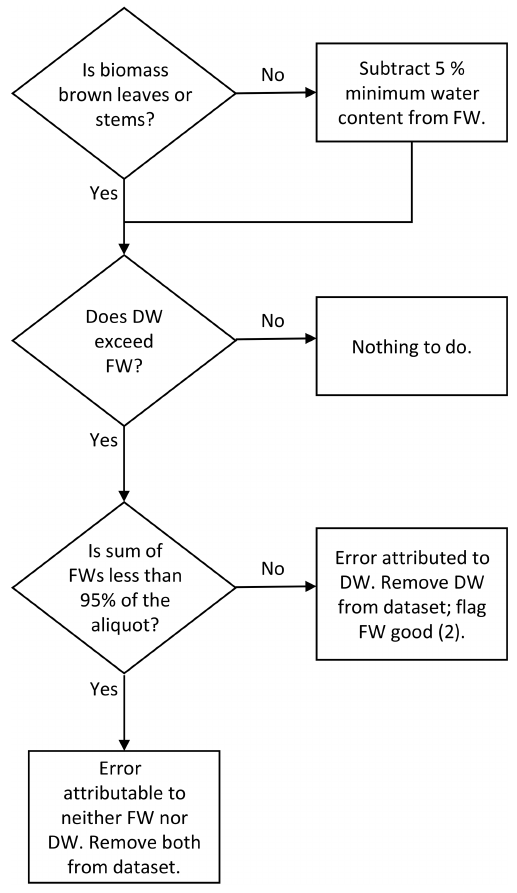
Figure 4. Flow chart of the decision process of quality assurance when fresh weight (FW) was found to be larger than dry weight